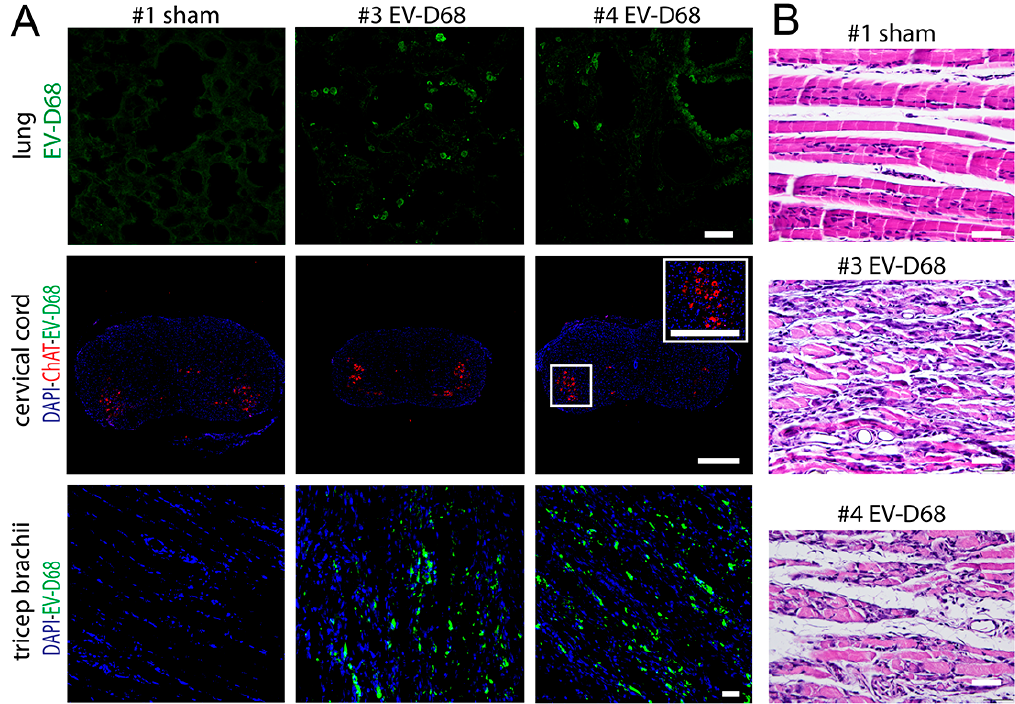
Figure 11. EV-D68 ir in muscle only with myositis and myofiber degeneration in AG129 mice challenged intranasally at 5 days of age and assayed at peak paralysis 8 days later. ( A ) EV-D68 ir in lung, ChAT ir and EV-D68 ir in cervical cord and EV-D68 ir in tricep brachii; ( B ) Hematoxylin-eosin (H&E) staining of bicep muscle in #1 sham, #3 EV-D68, and #4 EV-D68 AG129 mice at onset of paralysis eight days after viral challenge. 500 µm bar for cervical cord in ( A ). All other bars are 50 µm.